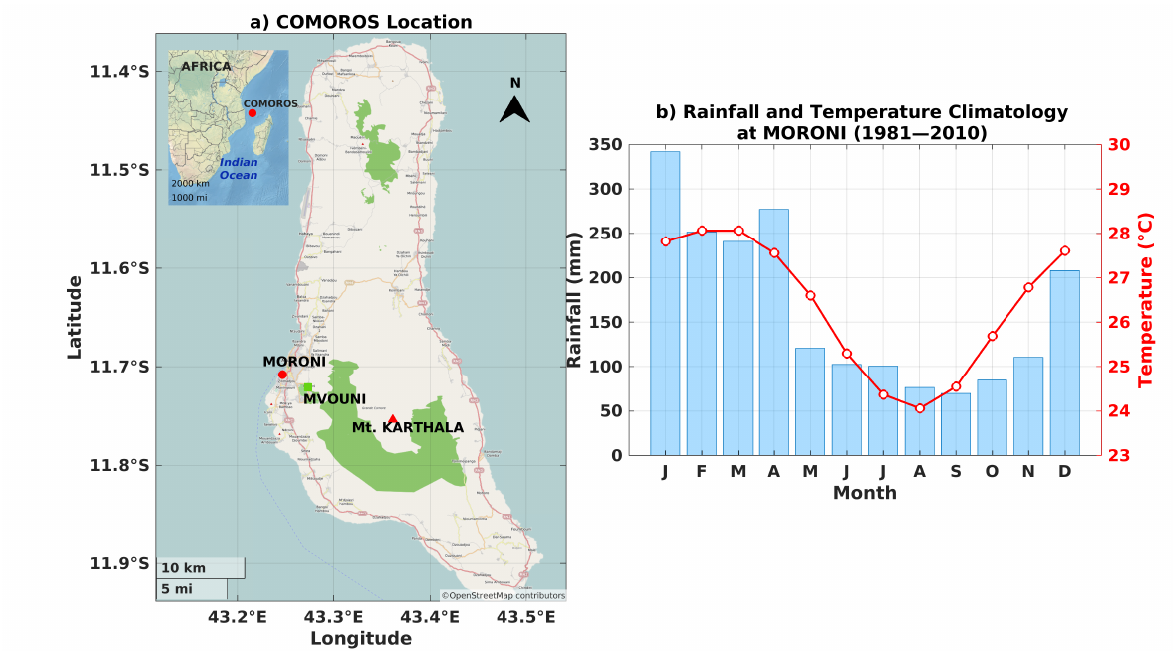
Figure 1. Context ( Map and Precipitation Climatology). ( a ) Comoros Location: town of Moroni (red dot), Mvouni Village (green square), and Mount Karthala (red triangle). ( b ) Rainfall (barplot) and temperature (red line) climatology at Moroni from 1981 to 2010